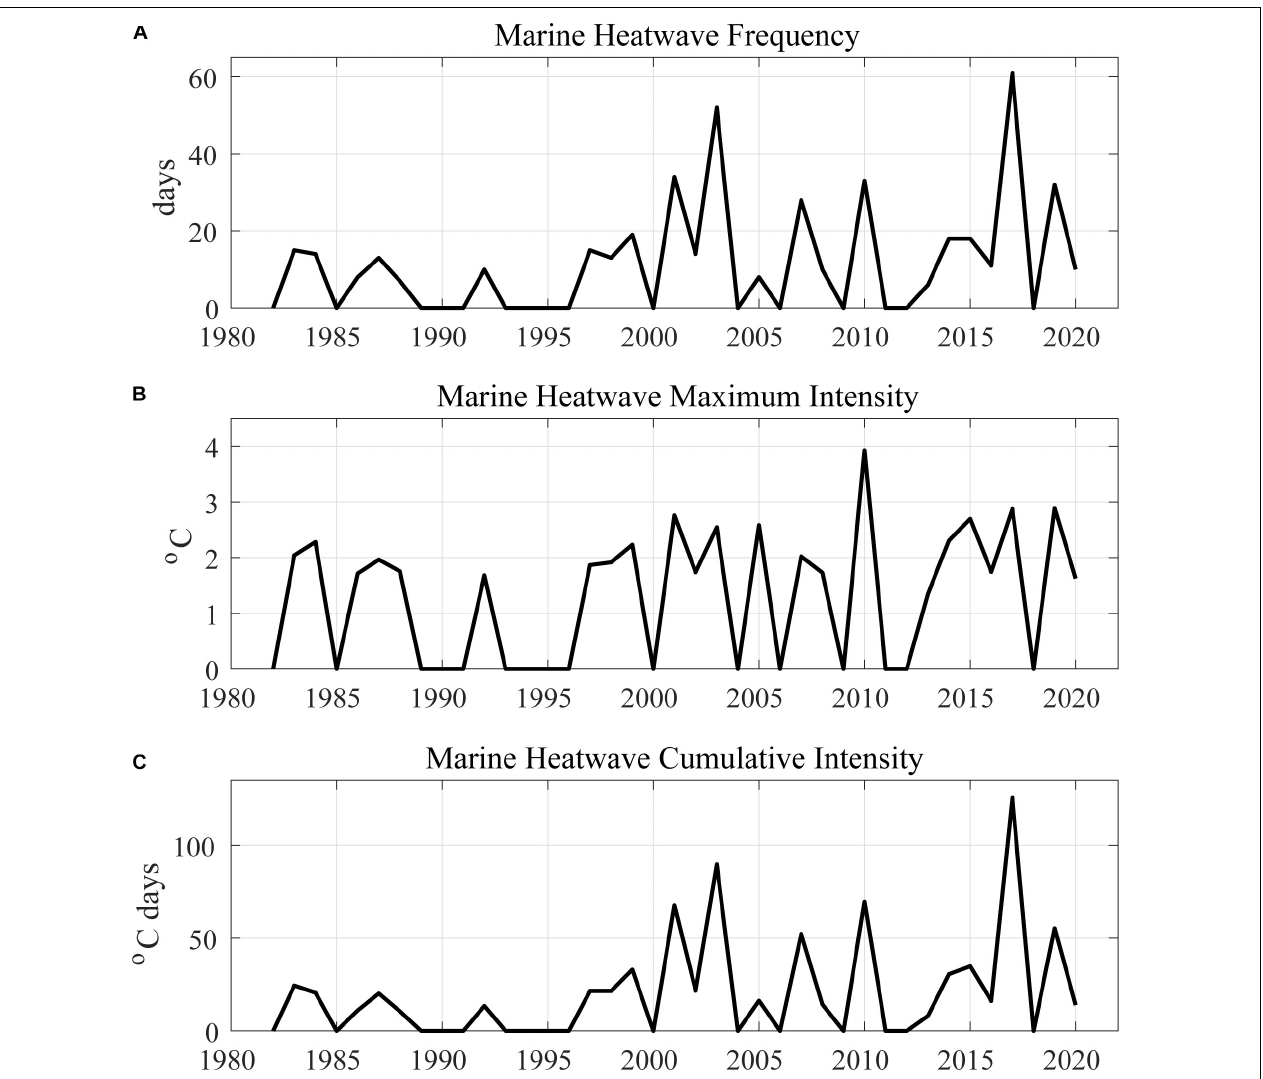
FIGURE 2 | Time series with marine heatwave metrics detected at 28.125 ◦ S 48.375 ◦ W for the Austral summer months (December–March). (A) Frequency in days per summer; (B) Maximum intensity in ◦ C per summer; and (C) Cumulative intensity in ◦ C Days per summer.